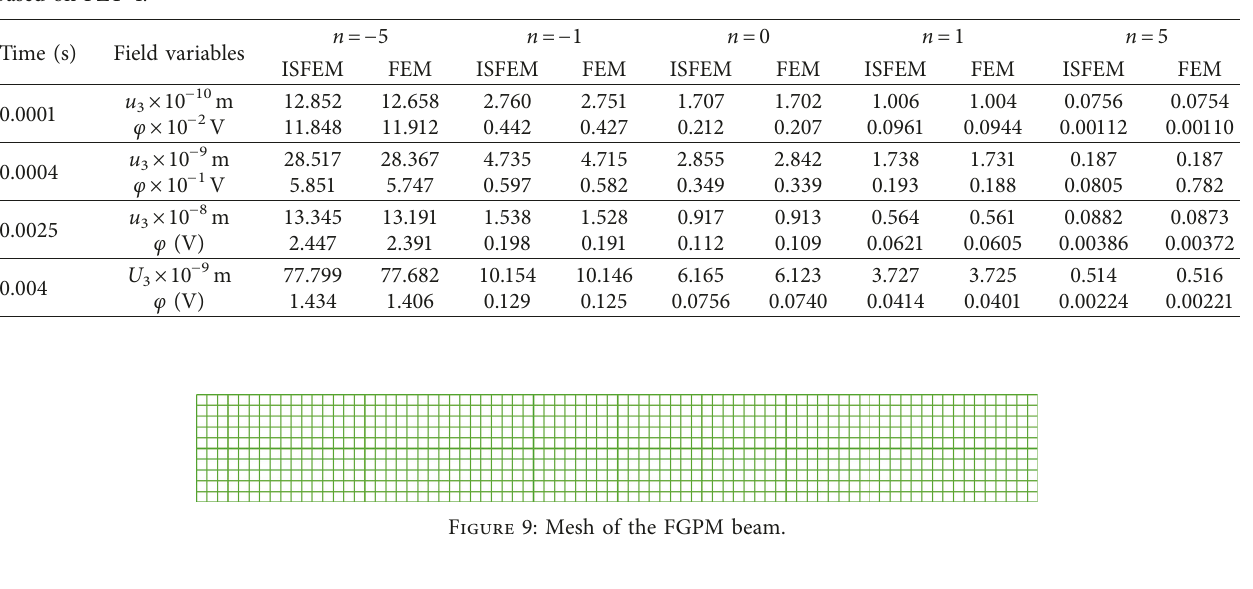
� − 5, − 1, 0, 1, and 5 of the FGPM beam